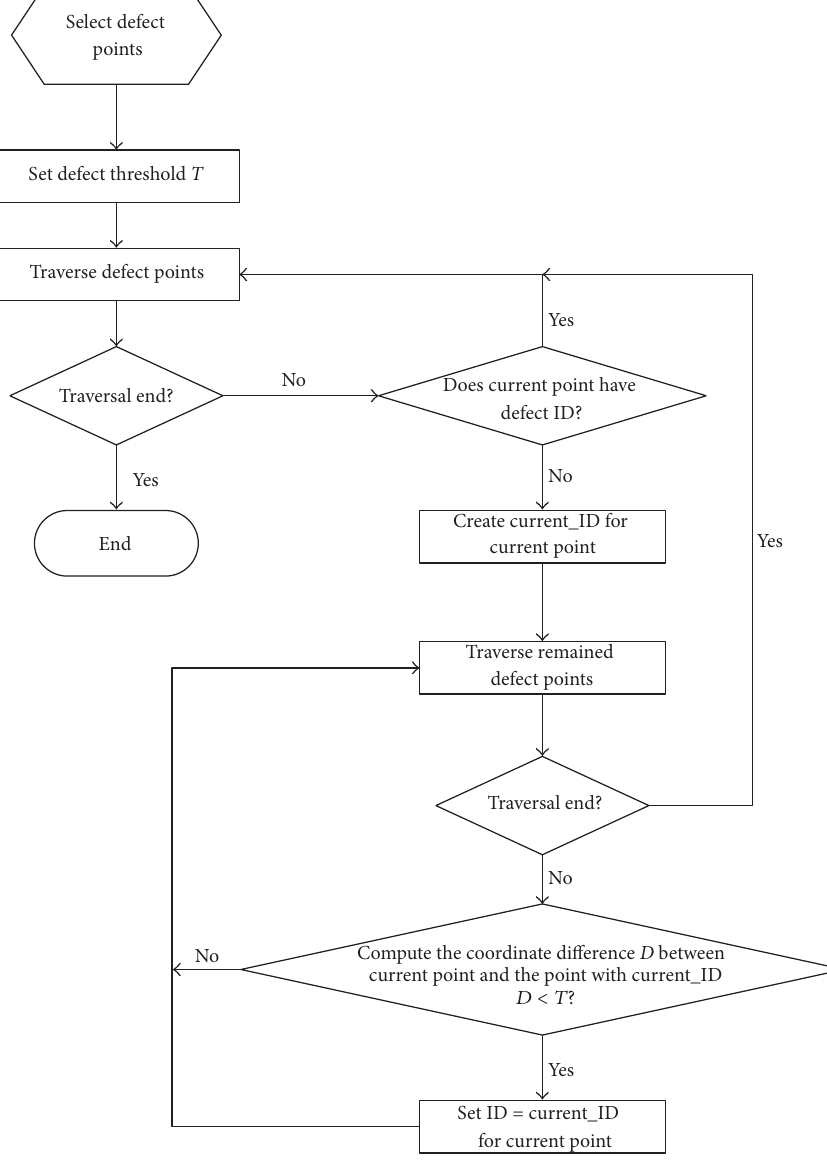
Figure 3: The flow graph on wood defect